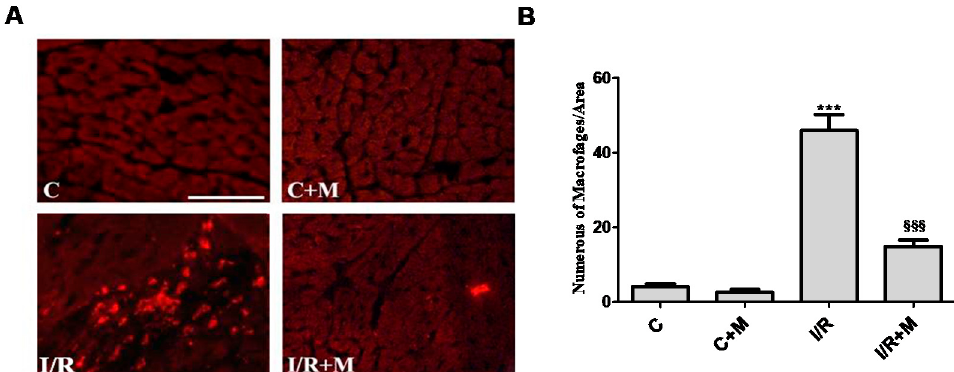
Figure 4. Metformin exerts anti-inflammatory activity in postinfarcted myocardium. ( A ) CD68 immunostaining was performed in order to detect inflammatory cell populations in cardiac sections from vehicle- or metformin-treated mice subjected to 30 min of cardiac ischemia and 14 days of reperfusion. Metformin treatment (5 mg/kg, i.p.) started at 15 min of reperfusion and continued for 14 days. Scale bar is 100 µ m. ( B ) Quantification of inflammatory cells from ( A ), n = 4–5. One-way ANOVA followed by Bonferroni’s post hoc test: *** p < 0.001 vs. control (C), §§§ p < 0.001 vs. I/R.